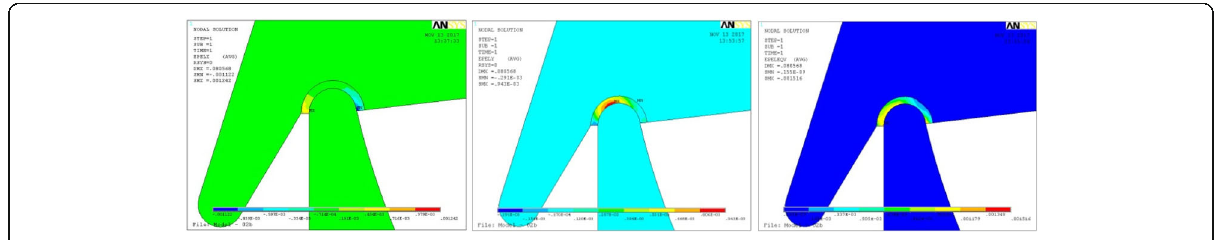
Fig. 3 Condylar strain in X and Y directions and total